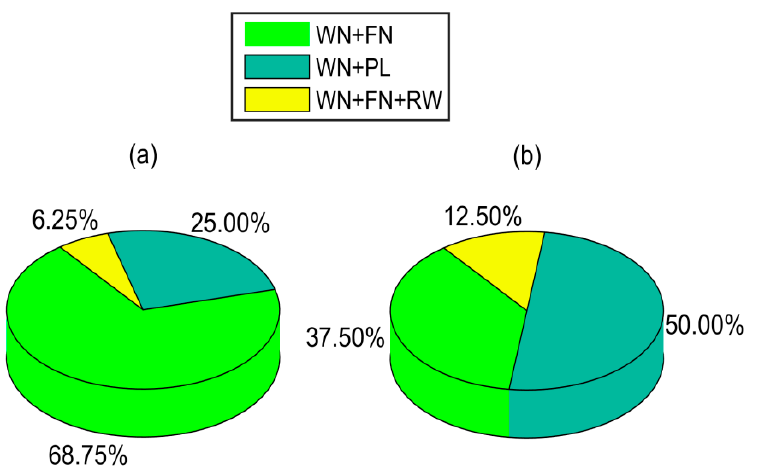
Figure 14. ( a , b ) represent the proportion of the optimal noise model in GPS station before and after the CME filtering, respectively.